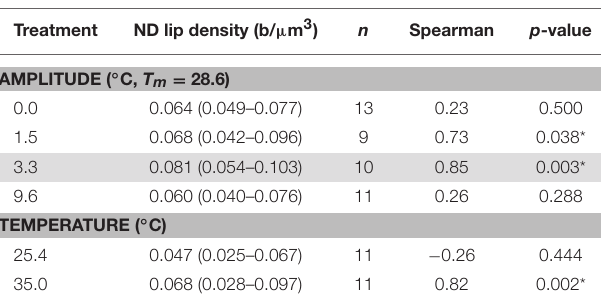
TABLE 3 | Correlation between synaptic bouton density in the non-dense (ND) MB calyx lip and thorax length for fluctuating and constant temperature